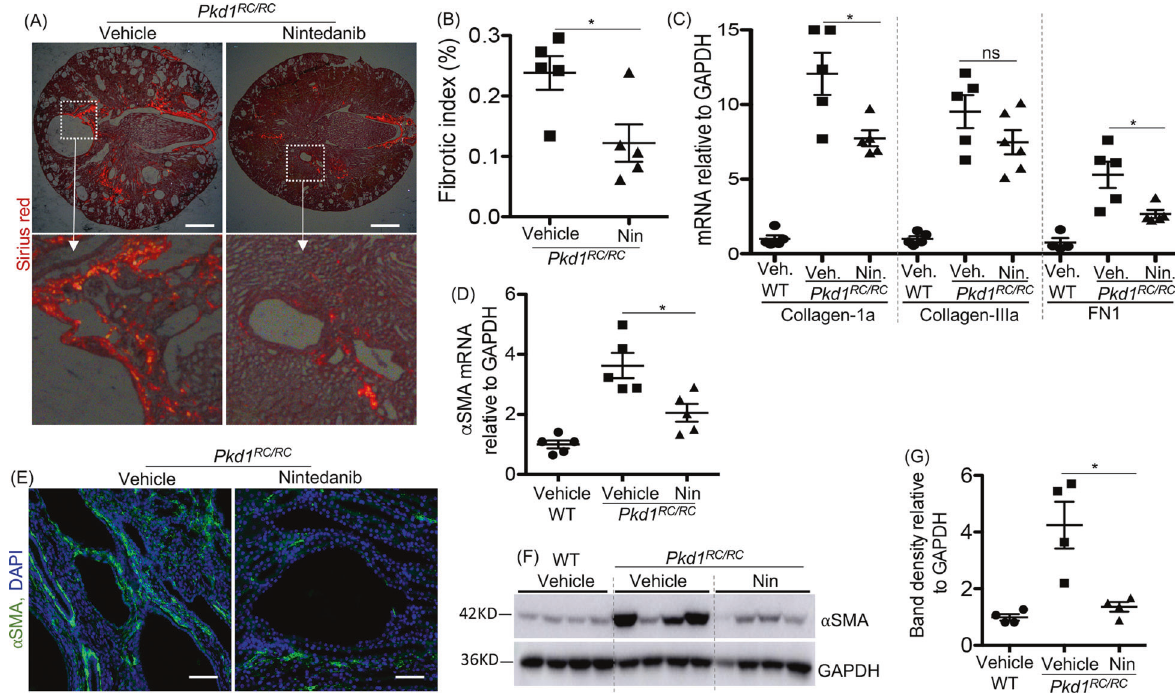
Fig. 3 Nintedanib (Nin) treatment reduced fi brosis in Pkd1 RC/RC mice. A Sirius red-stained tissue images under polarized light (scale bar = 1 mm) and ( B ) quantitation of fi brosis based on Sirius red staining. C Renal mRNA levels for ECM proteins. D Renal α SMA mRNA levels. E Immunostaining for α SMA (green) in mouse kidney tissue (scale bar = 50 µM). F Immunoblot for α SMA in kidney tissue and ( G ) quantitation of band density. * P < 0.05, ** P < 0. 01, *** P < 0.001 by T